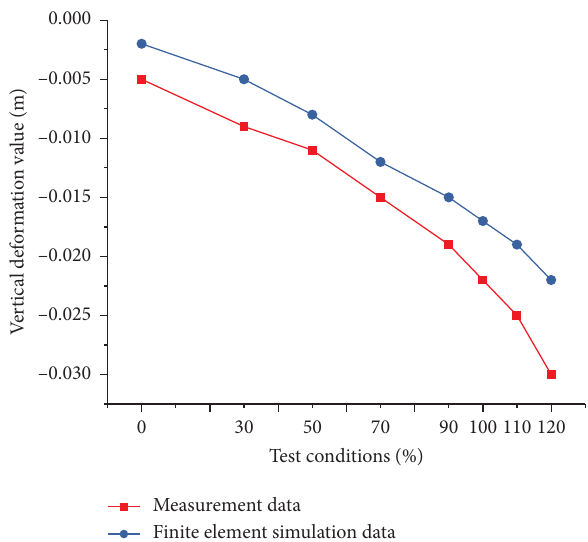
Figure 20: Comparison of the measured value and finite element simulation value.